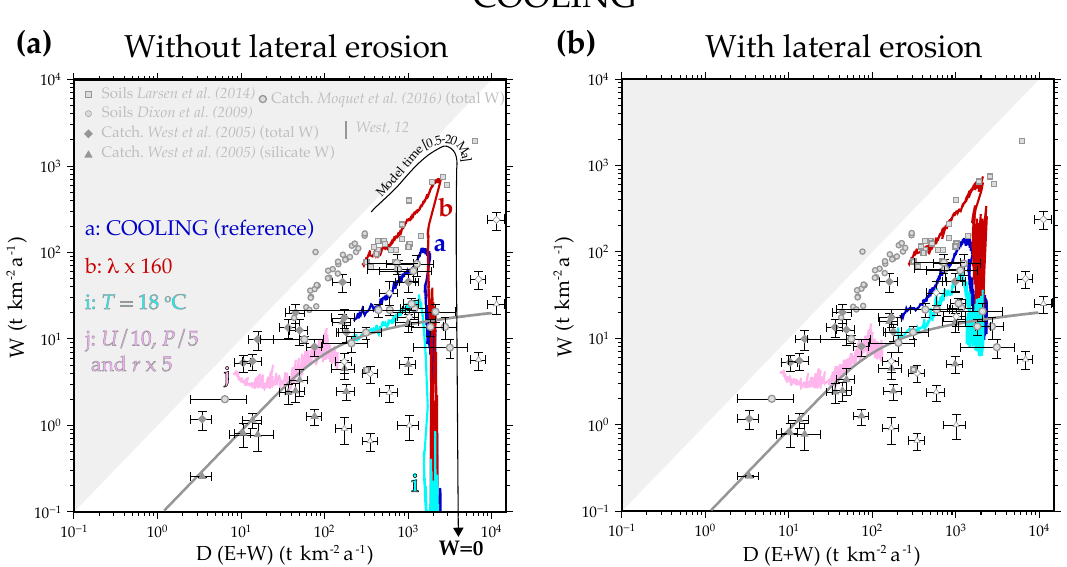
Figure 7. Different experiments with cooling climate. The temperature decreases with elevation ( − 6 ◦ Ckm − 1 ), the sea level temperature T decreases by 8 ◦ C in four steps, and the rainfall decreases − 5% per degree of cooling. Experiments a (COOLING), b, i, and j use the same parameters as in Fig. 4 but with a cooling climate. Without (a) and with ( α = 0.001) (b) lateral